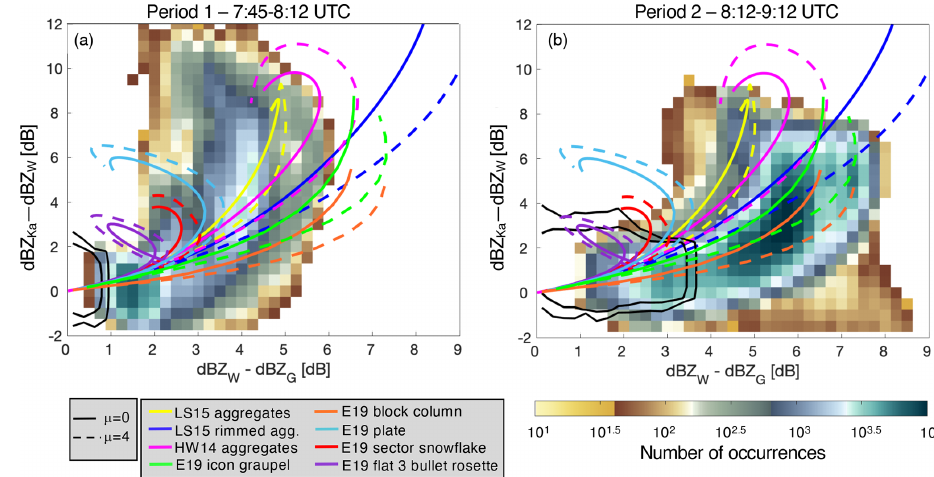
Figure 7. For observations collected (a) between 07:45–08:12UTC and (b) between 08:12–09:12UTC; distribution of Ka–W dual- wavelength ratio as a function of W–G dual-wavelength ratio for the cloud region between 2 and 5.5km altitude (color map) and for the cloud region between 5.75 and 7km altitude (contours). Lines represent effective reflectivity calculated using scattering models with differ- ent particle type (colors) and with different particle size distribution shape parameter (line type). More details about these scattering models are given in the